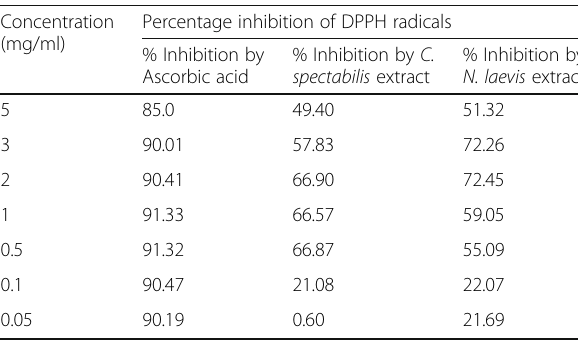
Values are expressed as mean of duplicate